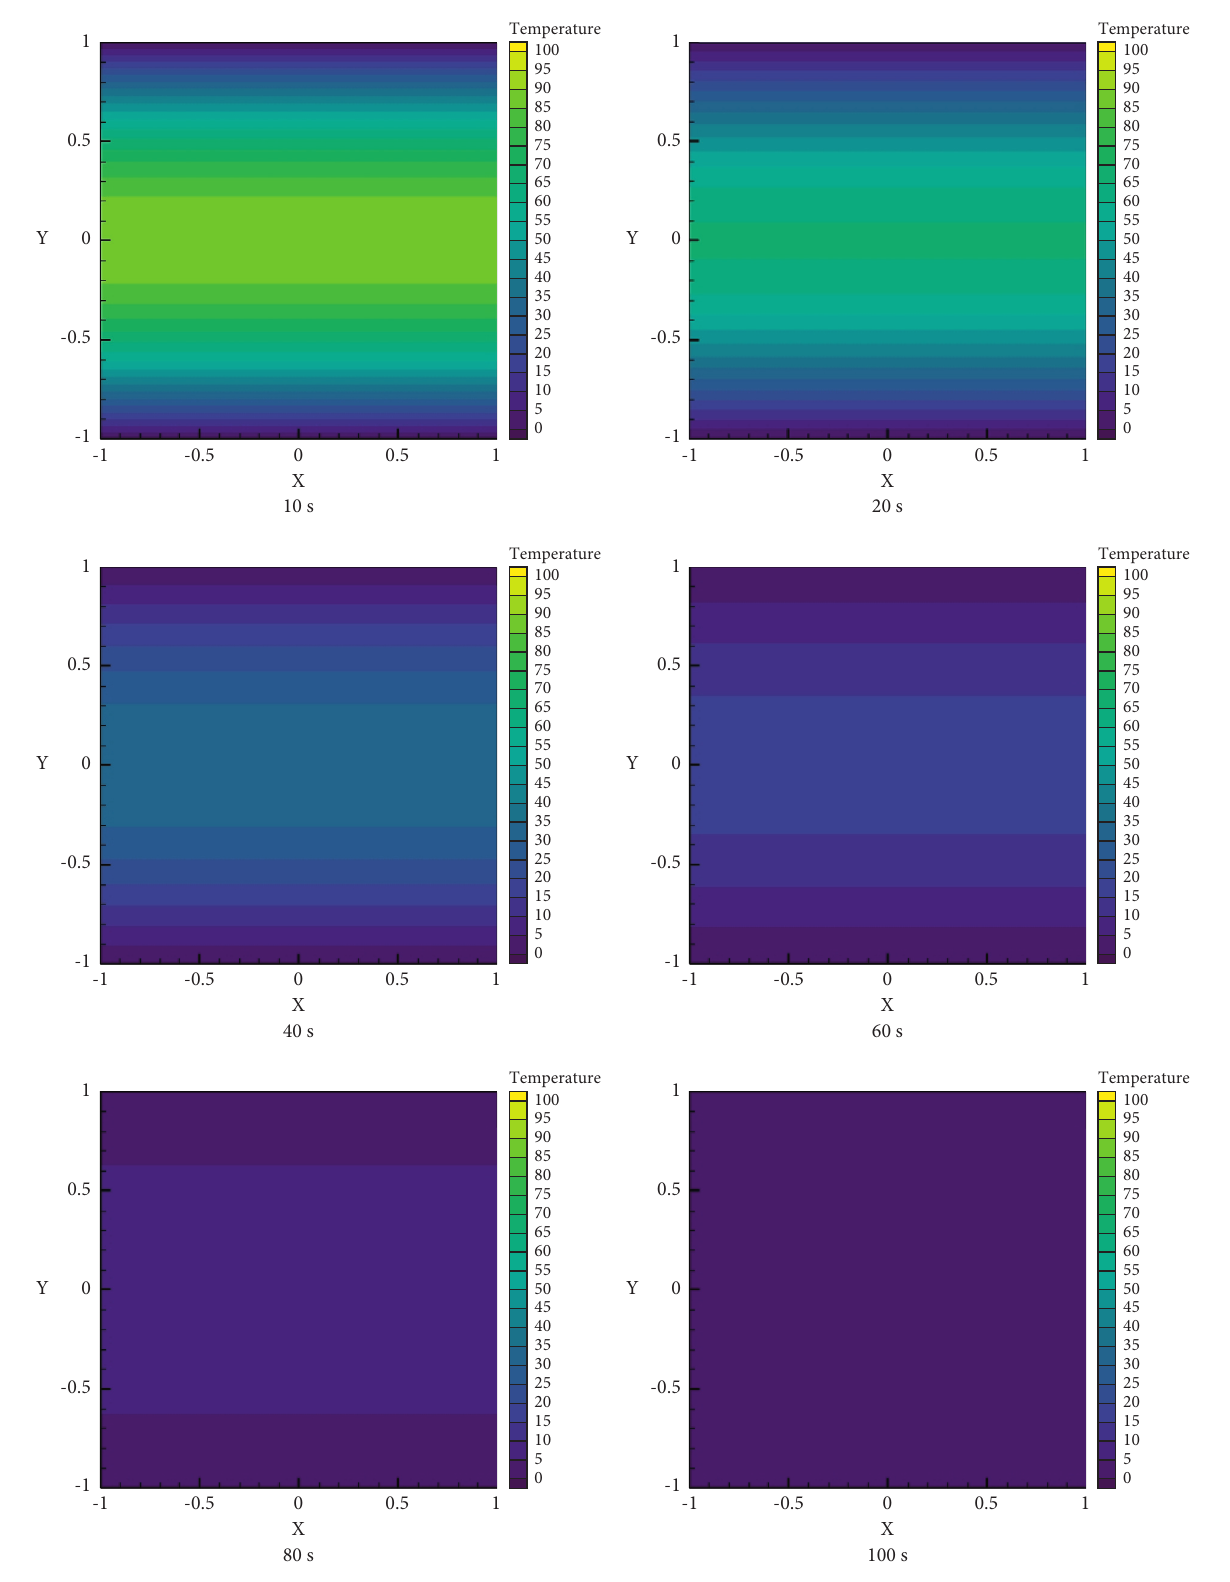
Figure 8: Temperature contours for time values of (a) 10, (b) 20, (c) 40, (d) 60, (e) 80, and (f) 100